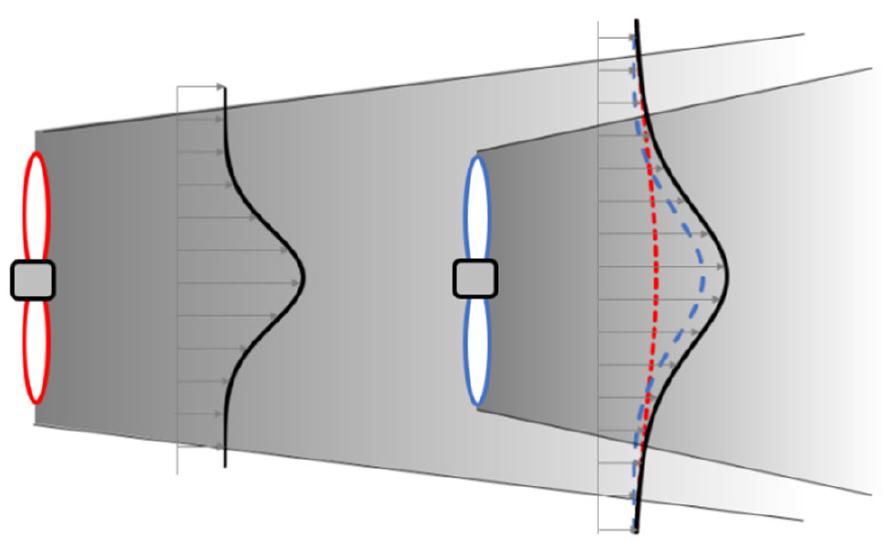
Figure 5. Wake superposition effect of two wind turbines. Table 5. Superposition approaches of multiple wind turbines.